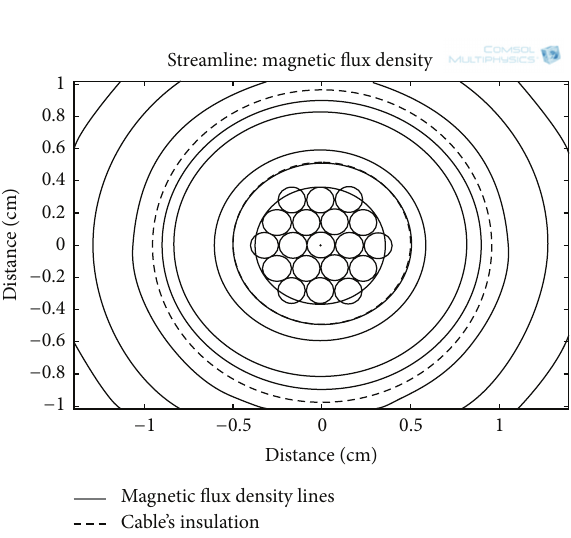
Figure 5: MFD lines along a cross-section of a single-core insulated cable at a current amplitude of 72